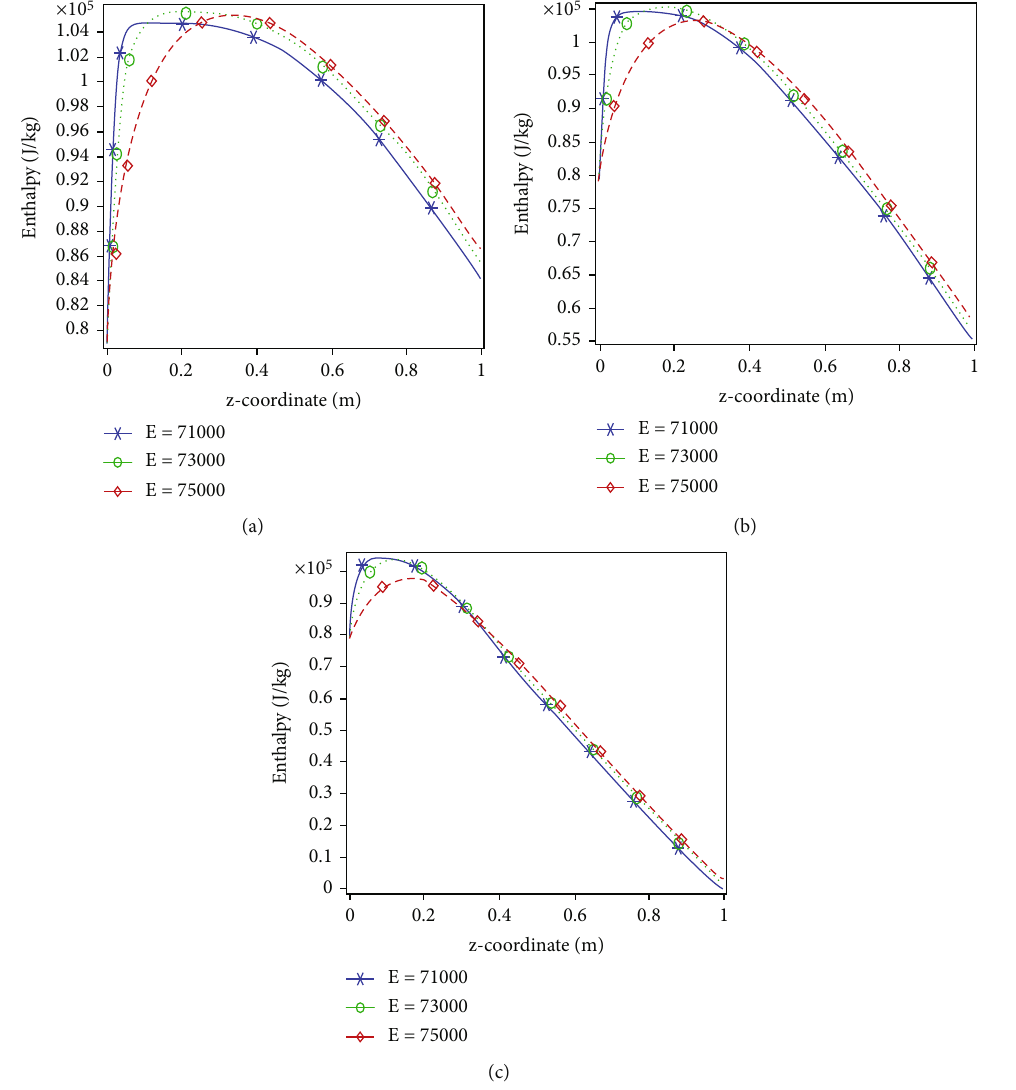
Figure 12: Measurement of enthalpy at upstream along the backward step channel against the axial direction at (a) Re = 100 , I : C = 1 % , a = 0 : 5 ; (b) Re = 100 , I : C = 1 % , a = 0 : 6 ; and (c) Re = 100 , I : C = 1 % , a = 0 : 7